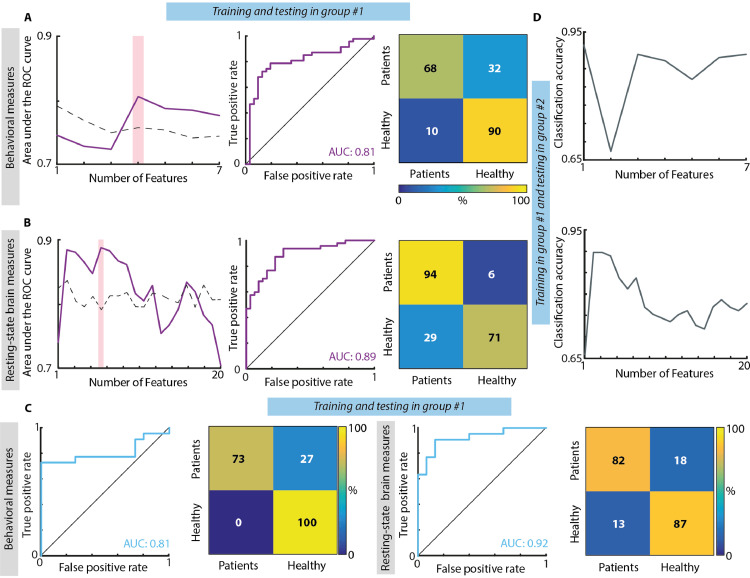
Results of classification between RHD patients and controls. (A) Classification based on behavioral measures of the SNT. Left: Area under the ROC curve with different number of features (purple line) and chance level based on permutation analysis (dashed line). The pink bar shows the optimal number of features selected (i.e., maximum AUC). Middle panel: ROC curve for the classifier obtained using the optimal number of features. Confusion matrix for patients and healthy controls for the classifier obtained using the optimal number of features. From top left clockwise: percent true positive, false negative, false positive, and true negative (hits, miss, false alarm and correct rejection, respectively). (B) Classification based on CVs of the five EEG-SVD components. The organization of the panel is the same used for the behavioral measures. (C) Classification results for the classifiers built training on the data of group #1 of day 1 and tested in the data of group #1 of day 2. Both for behavioral (1st and 2nd panels) and brain measures (3rd and 4th panels) we considered the features corresponding to the maximum AUC and we reported ROC curves (1st and 3rd panels) and confusion matrices (2nd and 4th panels). (D) Classification results for the classifiers built training on patients of group #1 and tested on patients of group #2. Top: classification accuracy with different number of features (grey line) for behavioral measures; bottom: classification accuracy with different number of features (grey line) for EEG-SVD measures.